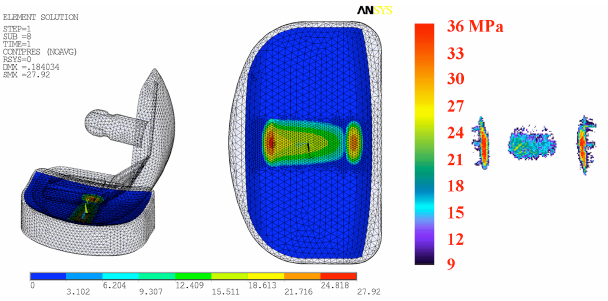
Fig.9. Free PE housing; Position